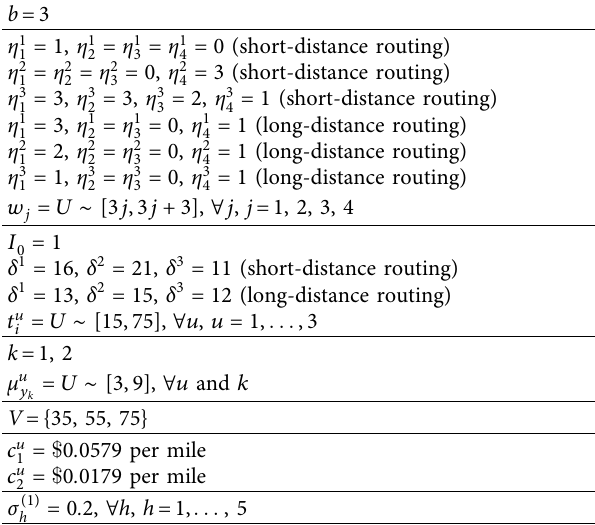
Table 5: A summary of parameter settings. b �